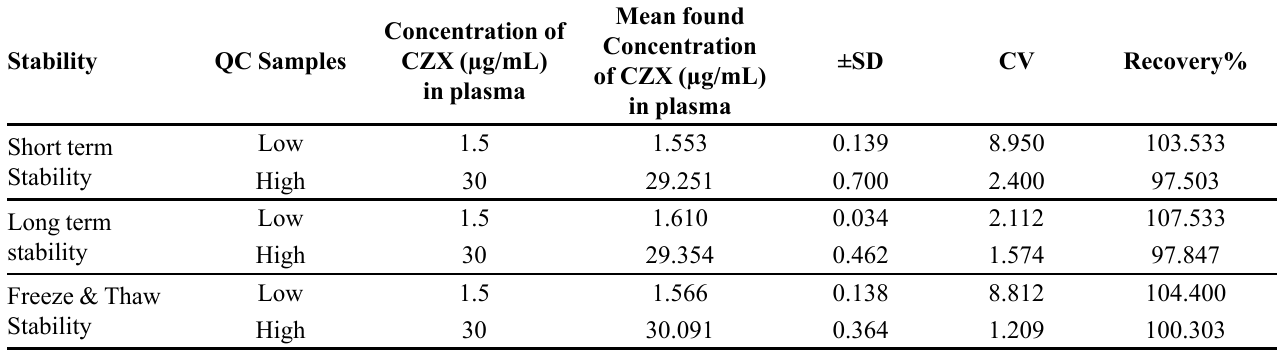
TABLE IV - The results of short, long and freeze and thaw Stability of chlorzoxazone in rat plasma